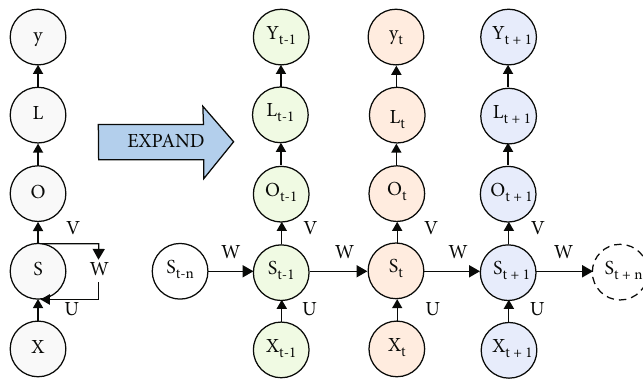
Figure 3: Structure of recurrent neural network.